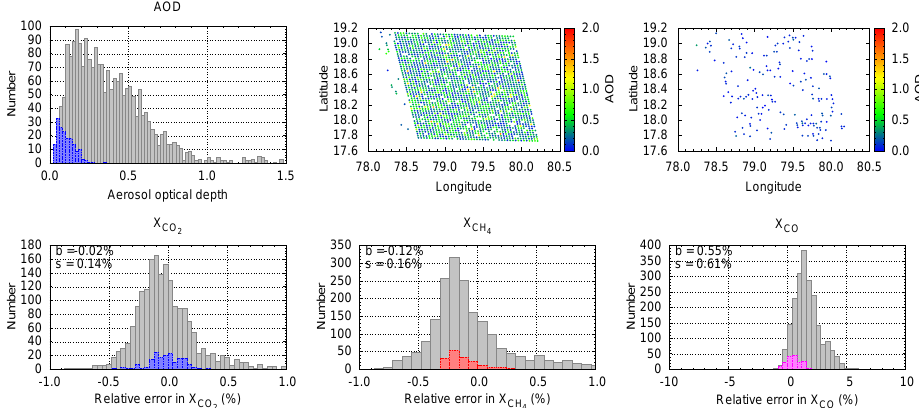
Fig. 22. The panels of the upper row show the histogram of aerosol optical depth and its spatial distribution. The points in the middle panel show the pixels where the retrieval algorithm converged, while those in the right-hand panel also passed the post-processing filter. The panels in the lower row show the histograms of errors in retrieved X CO , X CH and X CO , again before and after the post-processing 2 4 filter.